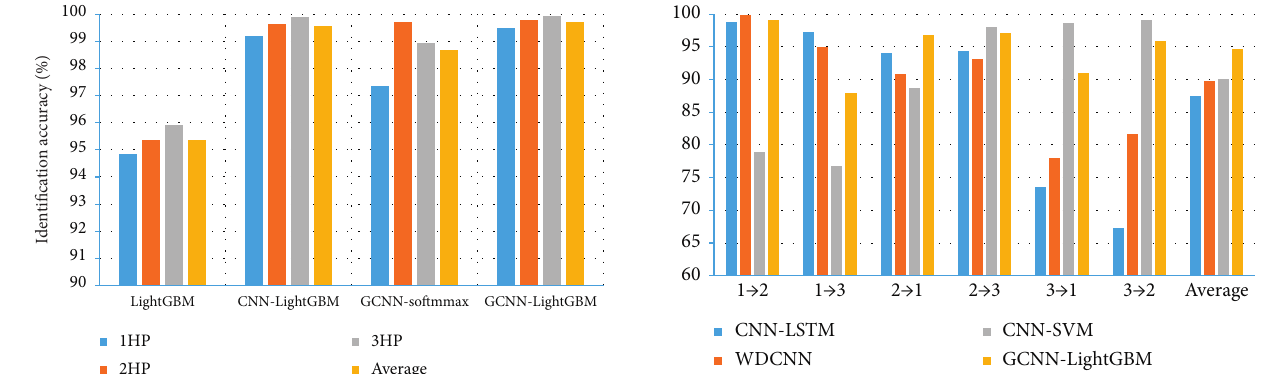
Figure 4: The classification accuracy of each model under the same load condition.